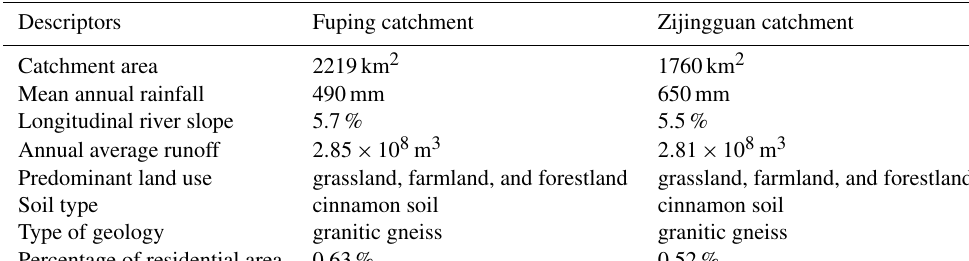
Table 1. The characteristics of the two sub-watersheds.